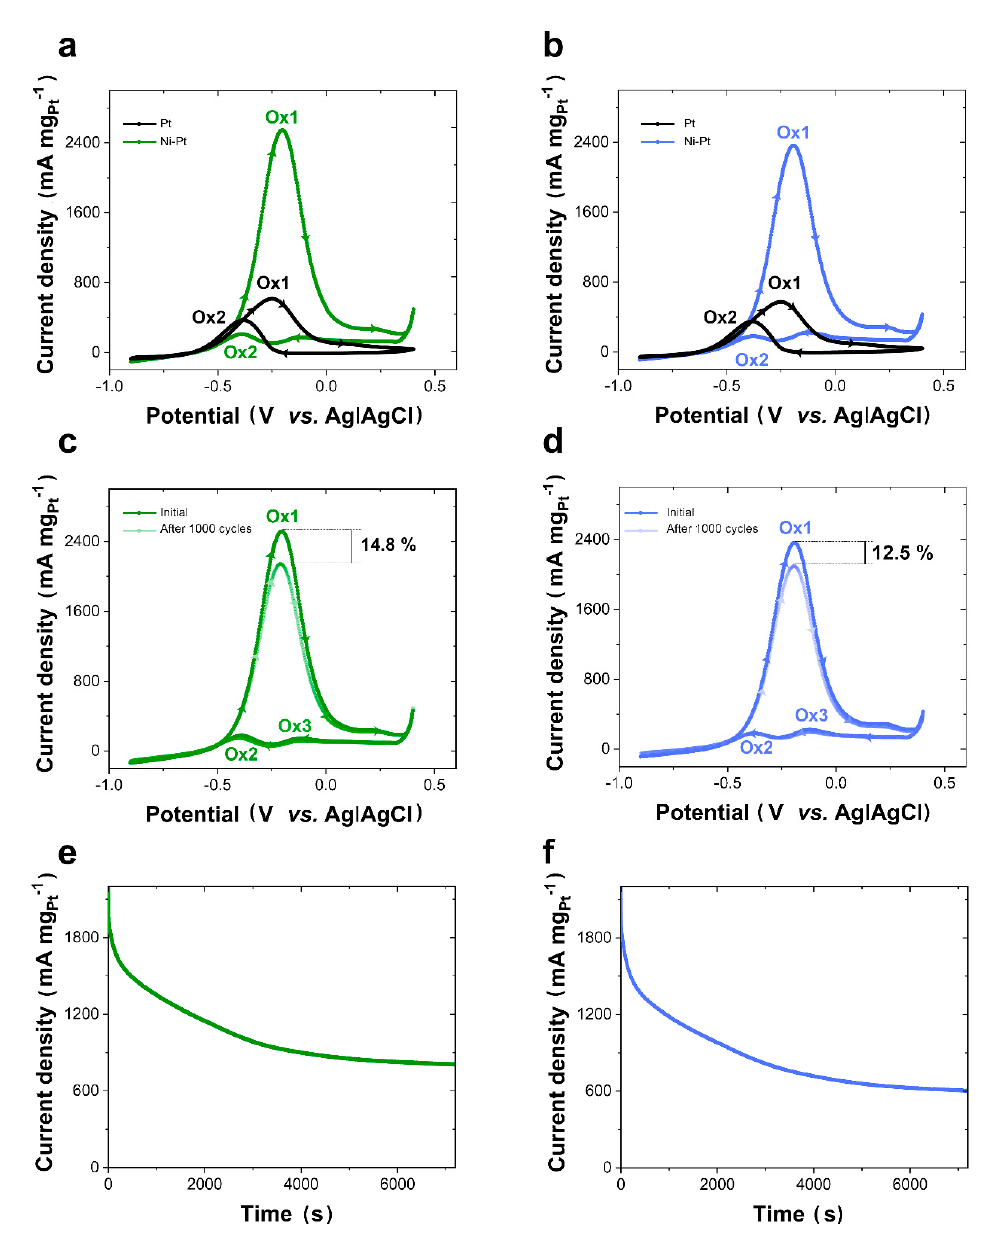
Figure 7. Cyclic voltammograms of methanol electro-oxidation in a solution containing 1 M of KOH and 1 M of methanol at a scan rate of 50 mV s − 1 for Pt and Ni-rich Ni-Pt mesoporous films electrodeposited on ( a ) FTO and ( b ) Si / Ti / Au substrates. Cyclic voltammograms of methanol electro-oxidation in a solution containing 1 M of KOH and 1 M of methanol at a scan rate of 50 mV s − 1 before and after 1000 cycles for Ni-rich Ni-Pt mesoporous films deposited on ( c ) FTO and ( d ) Si / Ti / Au substrates, along with chronoamperometric curves recorded at − 0.15 V versus Ag | AgCl for 7200 s for Ni-rich Ni-Pt mesoporous films deposited on ( e ) FTO and ( f ) Si / Ti / Au substrates. T = 25 °C. The long-term stability and durability of electrocatalysts are important parameters in determining whether Ni-rich Ni-Pt mesoporous films are promising applicable electrocatalysts for fuel cells. The durability of electrocatalysts was, therefore, initially evaluated with cyclic voltammetry (i.e., 1000 cycles using the same potential window and a scan rate of 100 mV s − 1 ) and